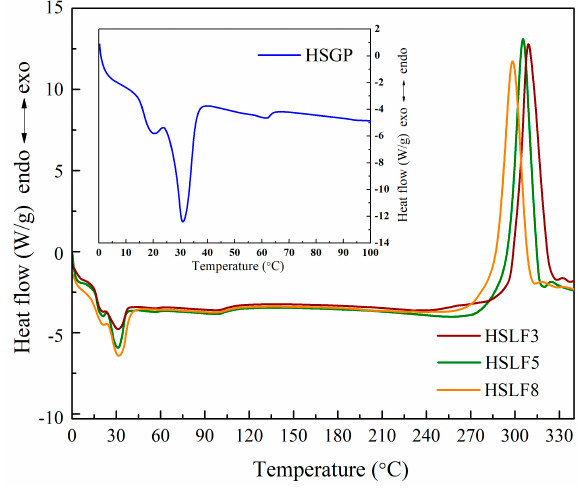
Figure 4. DSC curves of HSLFs and HSGP (inset).